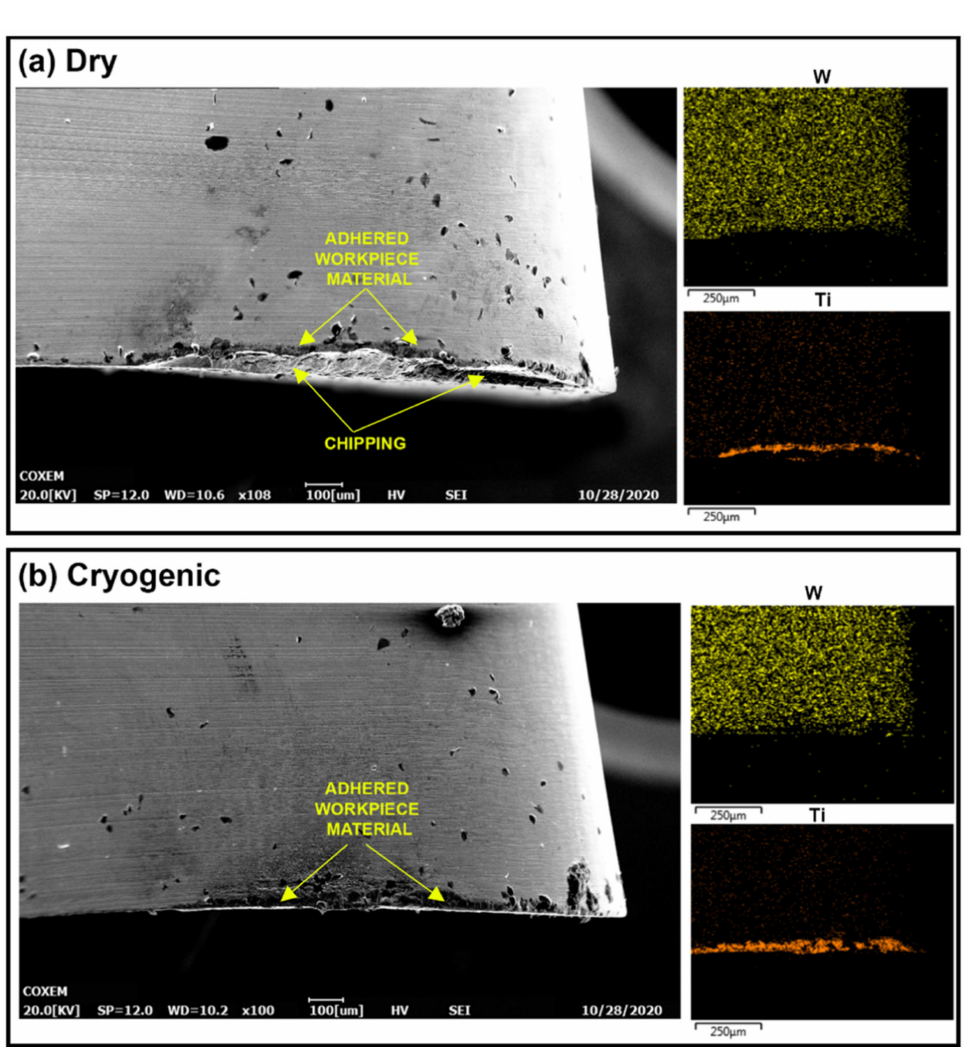
Figure 19. SEM and EDS element maps for the flank face in ( a ) dry and ( b ) cryogenic longitudinal